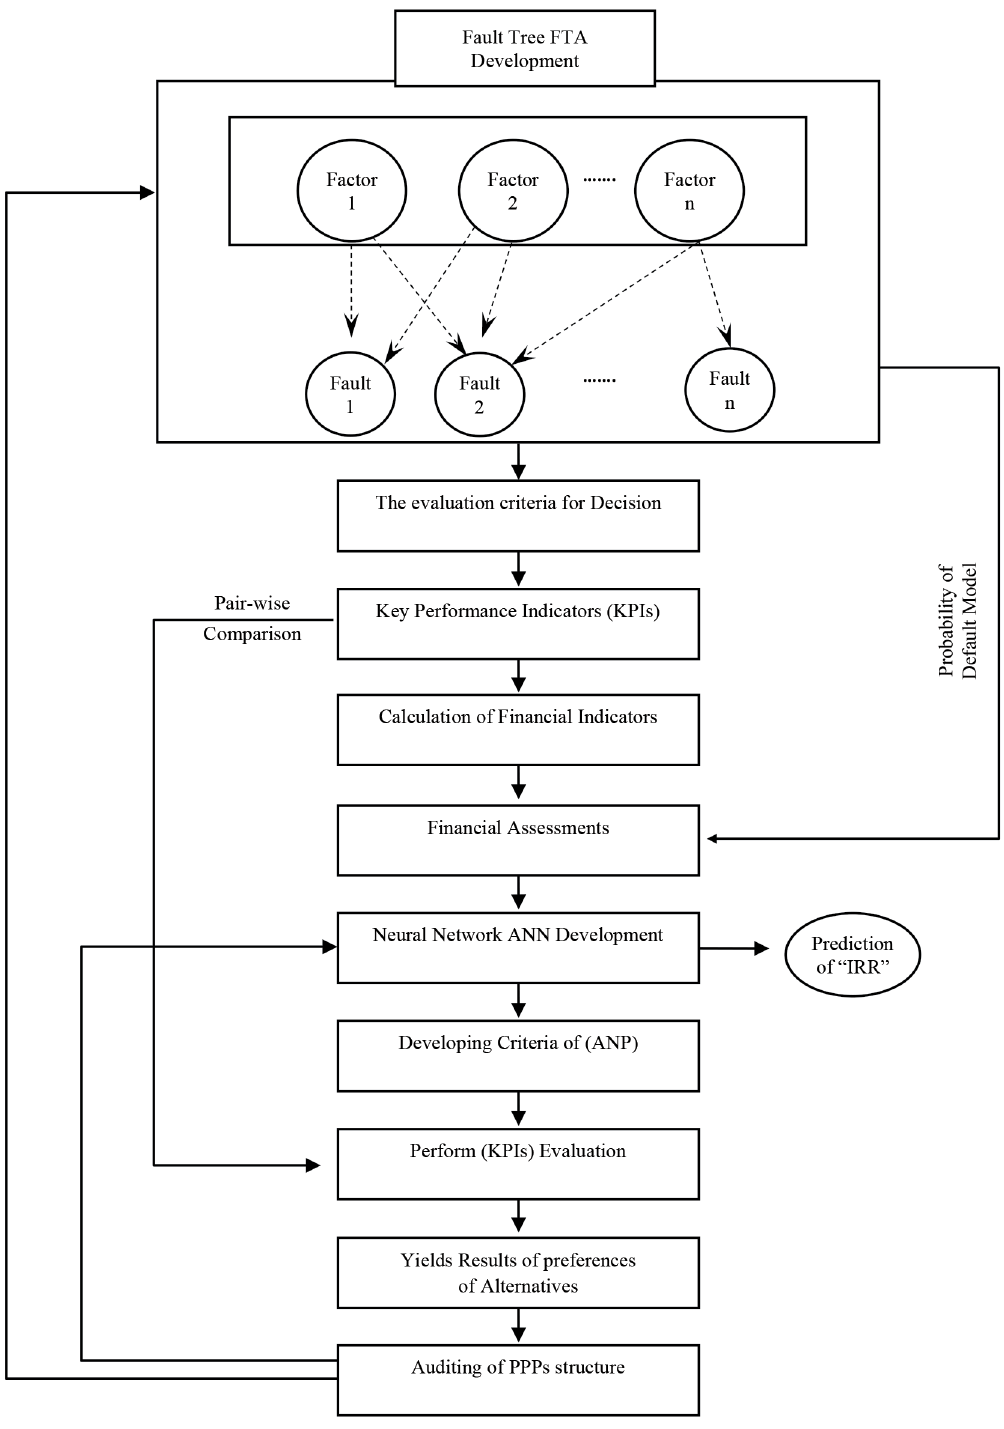
Figure 1. Flow chart of the proposed